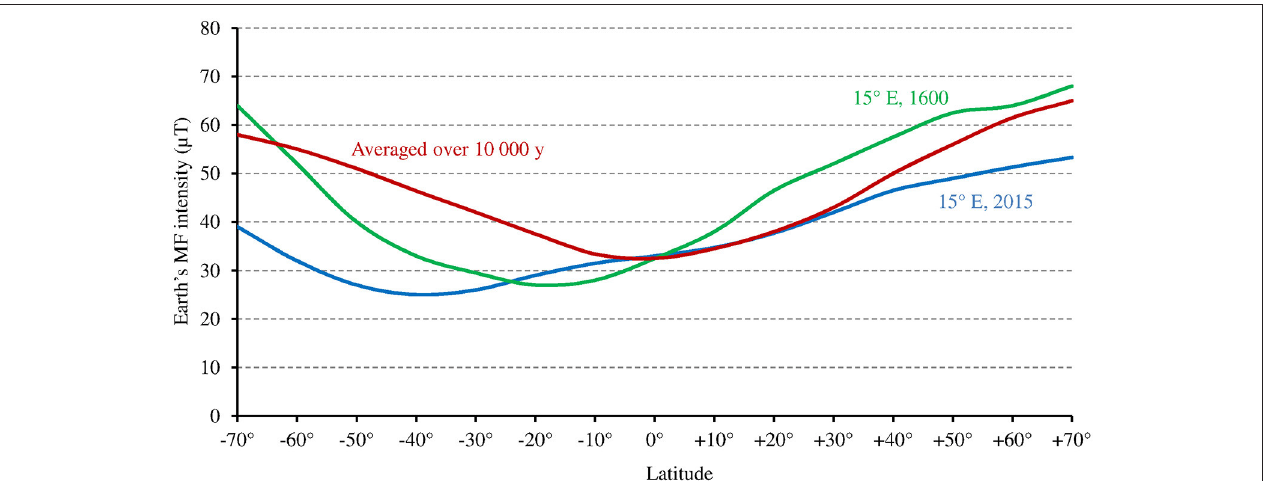
FIGURE 7 | Relation between Earth’s MF intensity and latitude, averaged over the last 10,000 years according to the models CALS10k.2 or HFM.OL1.A1 (standard deviation is 2–5 µ T) (adapted with permission from Constable et al., 2016, © Elsevier B.V.), and at 15 ◦ longitude E, where the studies by Stenøien et al. (2002) and Ranade and García-Gil (2013) (see text) were performed, respectively in the year 1600 (source: World data center for geomagnetism, Kyoto, http://wdc.kugi.kyoto-u. ac.jp/), and in 2015 (source: World Magnetic Model 2015,